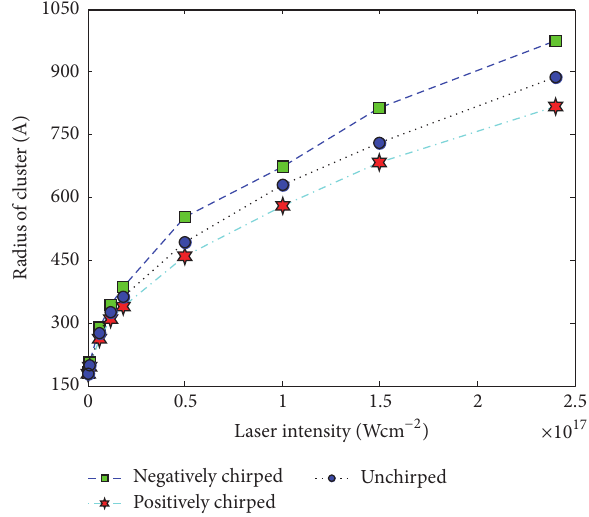
Figure 5: The variations in cluster size by changing the laser intensity at the different laser pulse shapes with 40 fs duration pulse and wavelength of 825